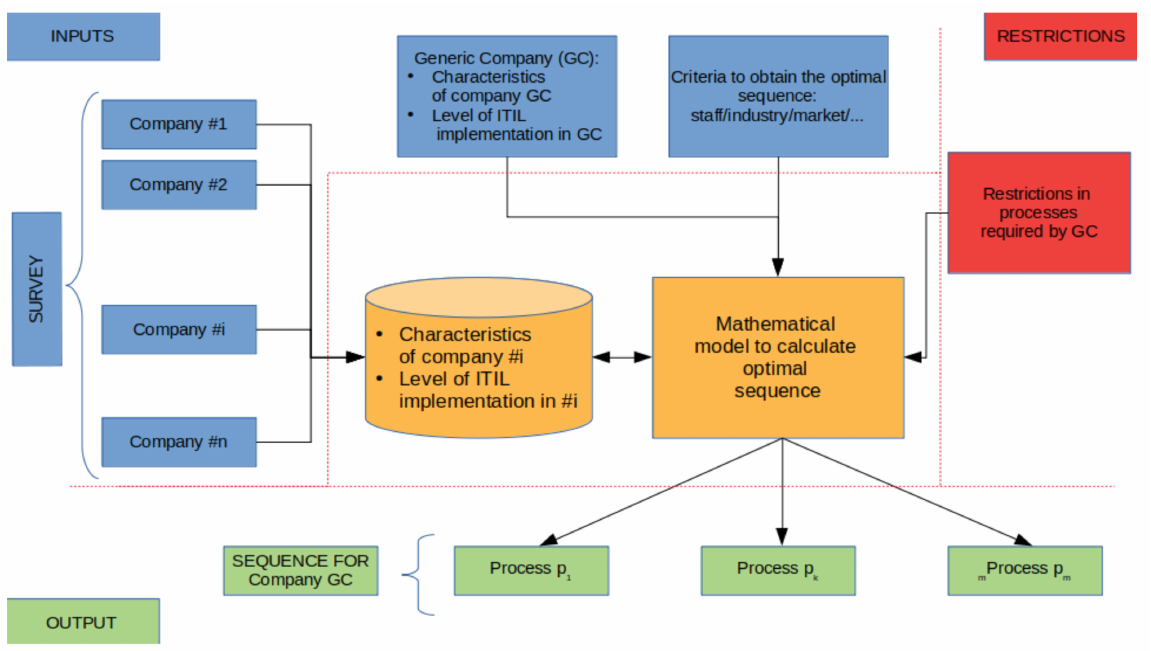
Figure 1. Materials and